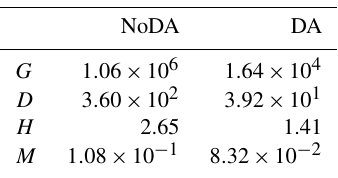
Figure 2. Time series of (a) the high water level W(t) , (b) the flood protection level (or levee height) H(t) , (c) the distance of the center of the mass of the human settlement from the river D(t) , (d) the size of the human settlement G(t) , (e) the intensity of flooding events F(t) , and (f) the social awareness of the flood risk M(t) simulated by the data assimilation experiment in which the observations of F , G , D , H , and M are assimilated into the model every 10 years, with 5000 ensembles, in experiment 1 (see Sect. 3.1.1). The time step is annual. Gray, red, and black lines are the ensemble members, their mean, and the synthetic truth, respectively. Table 2. RMSE of the no data assimilation (NoDA) experiment and the data assimilation (DA) experiment in which all observations are assimilated every 10 years, with 5000 ensembles, in experiment 1 (see Sect. 3.1).